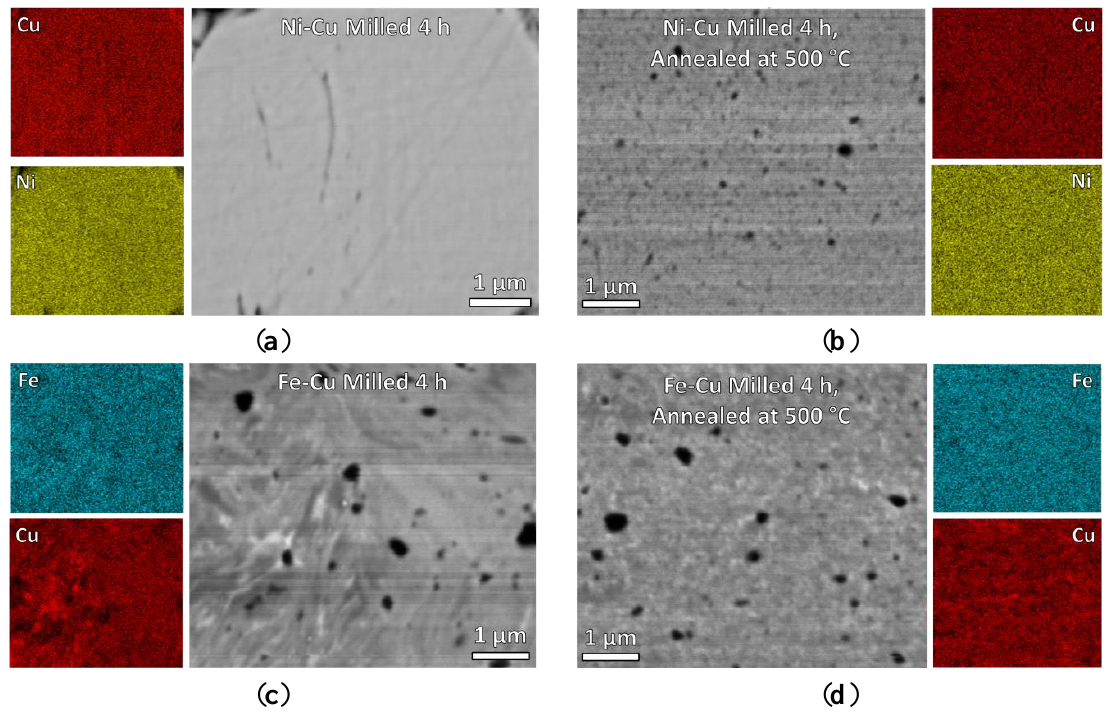
Figure 4. SEM and corresponding EDS mapping for ( a ) Ni 30 at% Cu milled for 4 h; ( b ) Ni 30 at% Cu milled for 4 h then annealed at 500 °C; ( c ) Fe 30 at% Cu milled for 4 h; and ( d ) Fe 30 at% Cu milled for 4 h then annealed at 500 °C.